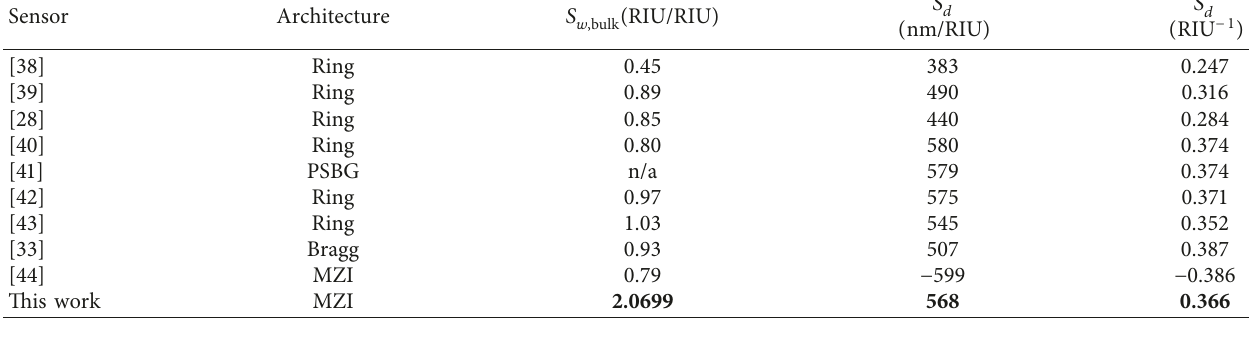
Table 7: Comparison of bulk sensitivity of λ 0 Sensor